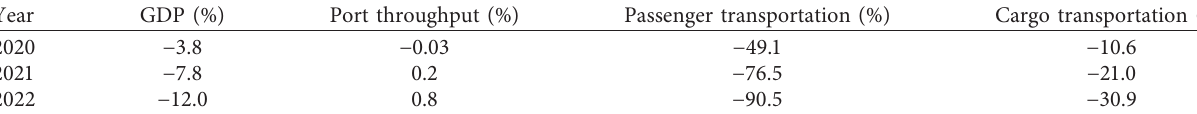
Table 7: The impact of COVID-19 epidemic on the main variables when epidemic is aggravated.